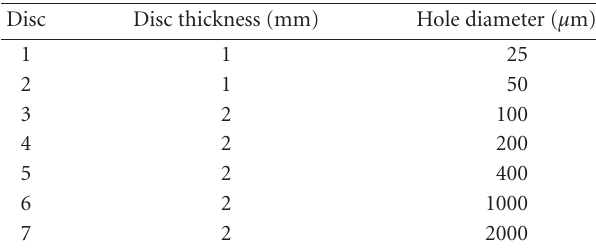
Table 1: The geometrical parameters of the tungsten